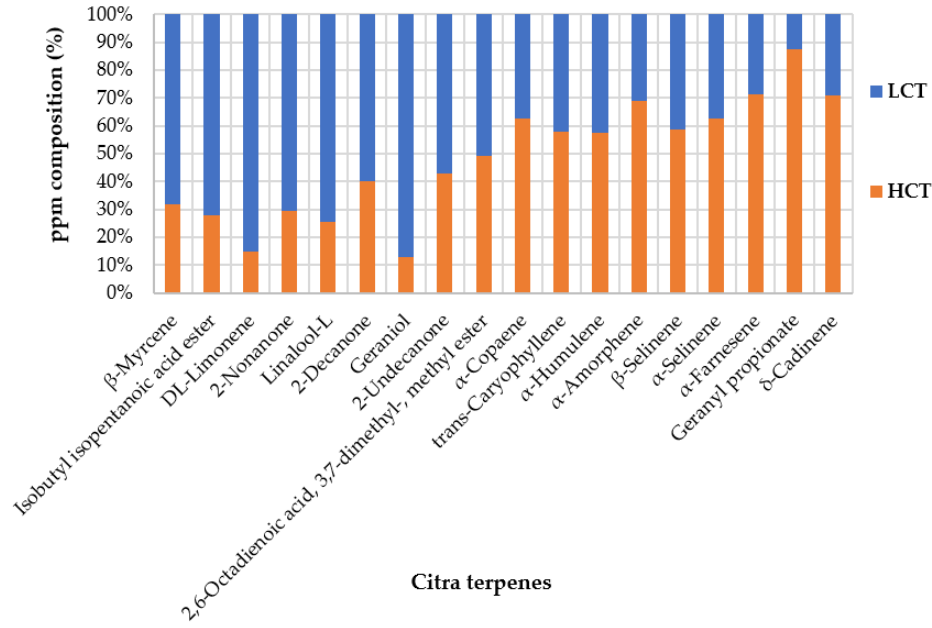
Figure 5. Hundred percent stacked column representation of the average ppm data from Table 7.